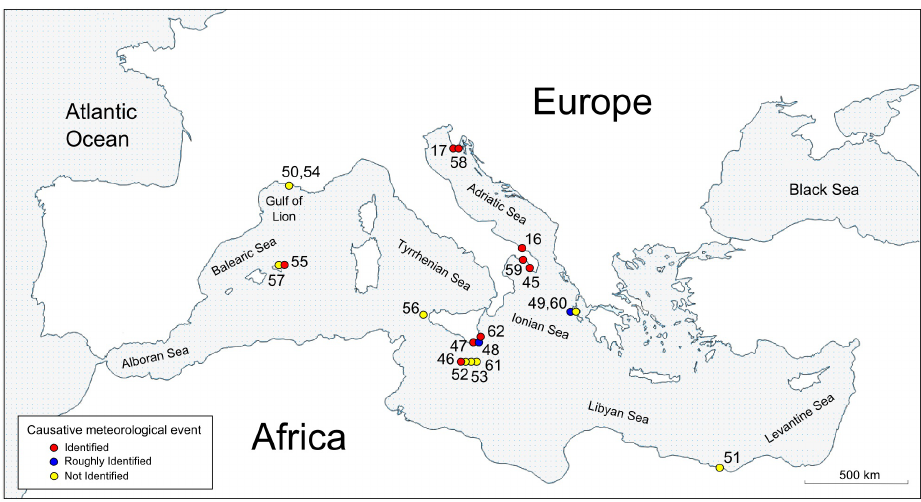
Figure 3. Locations of the reviewed case studies (see References